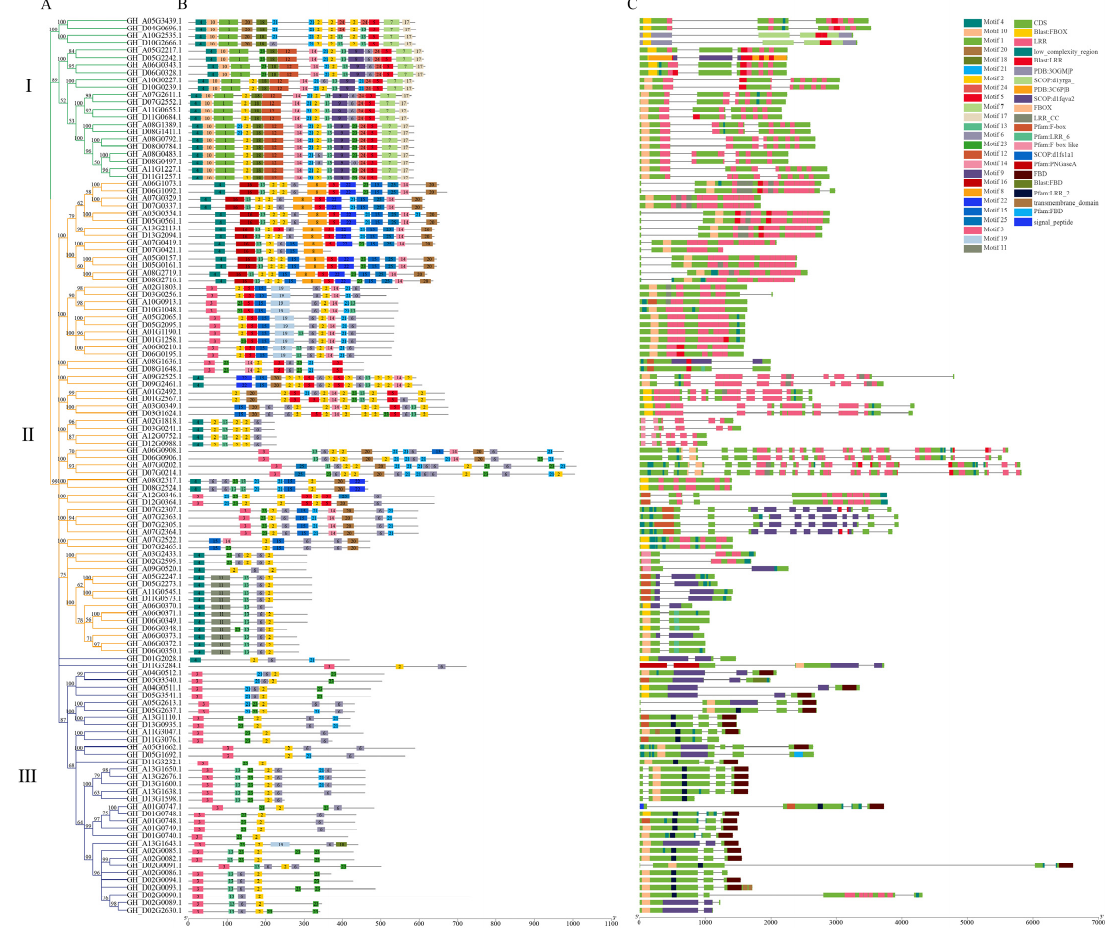
Figure 2. The conserved motifs, exon–intron structures of GhFBXLs . ( A ) Phylogenetics tree of GhFBXL genes. Used maximum likelihood (ML) method in MEGA7.0 software to create the phylogenetic tree. ( B ) Gh FBXL protein Motif prediction. ( C ) Analysis of exon—intron and gene structure of GhFBXL genes. (I: Grpup I; II:Group II; III: Group III).